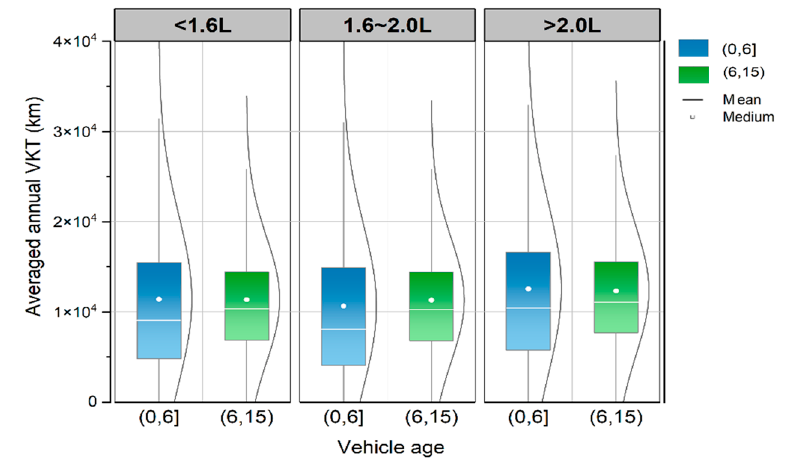
Figure 4. Annual VKT by engine size and vehicle age.